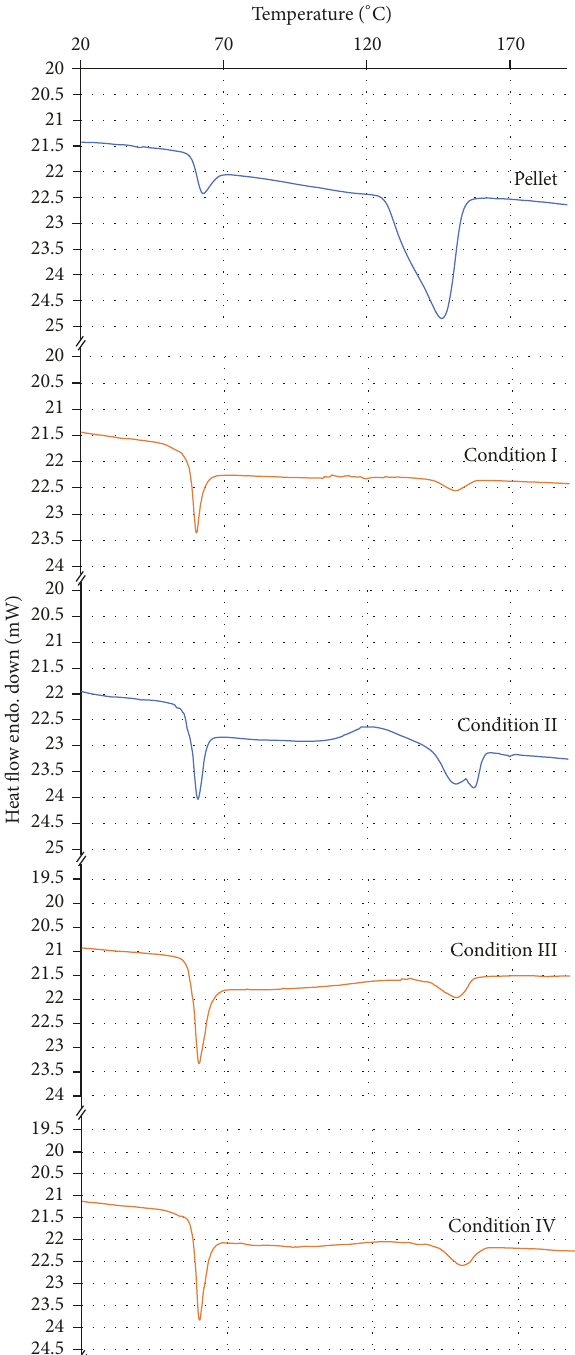
Figure 7: Calorimetry curves for PLGA pellets and molded specimens under different process conditions (I, II, III, and IV).